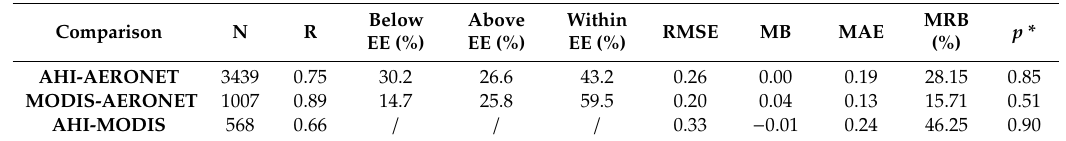
Figure 2. Evaluation of AHI ( a ) and MODIS AOD with QA = 2, 3 ( b ) AOD values at 500 nm against AERONET AOD as well as AHI against MODIS ( c ) in China from February 2018 to January 2019. Table 2. Statistics of comparison of AHI, MODIS and AERONET AOD values at 500 nm in China from February 2018 to January 2019.